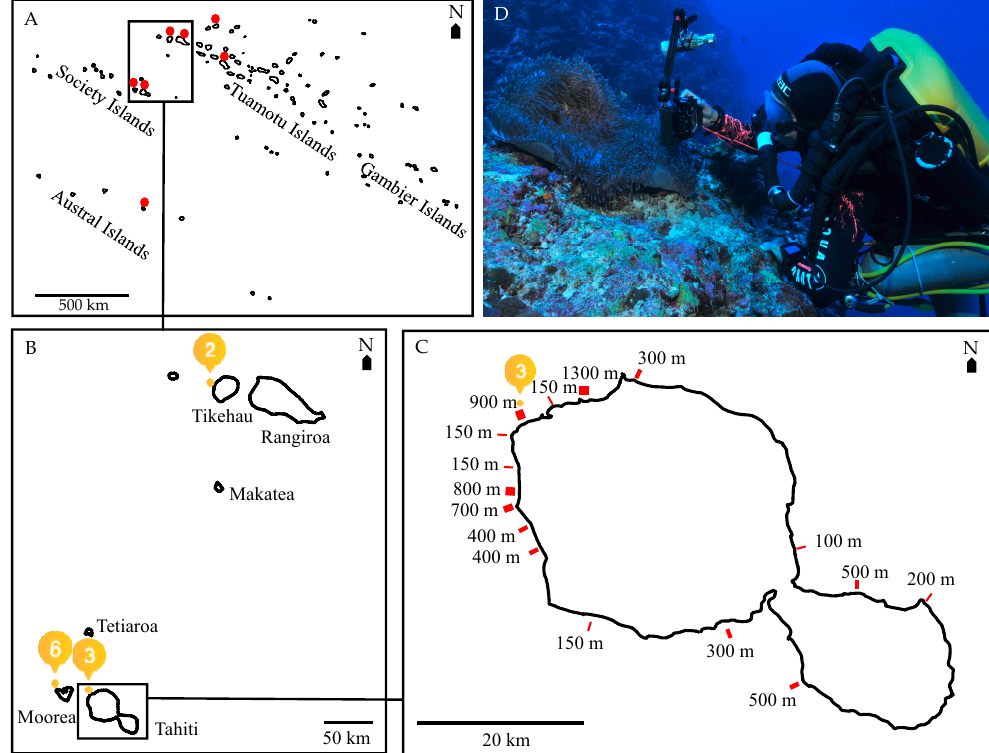
Figure 1. Anemone and anemonefish surveying in French Polynesia. ( A ) Map of French Polynesia indicating the seven high islands/atolls that were surveyed from 2011–2021 (black triangles: no anemonefish found, red triangles: only shallow anemonefish found, blue triangles: presence of anemonefish at both shallow and mesophotic depths). ( B ) Map of the three high islands/atolls where orange-fin anemonefish, Amphiprion chrysopterus , were observed both in the shallow and mesophotic zone (>50 m depth): Moorea (17 ◦ 28.870 (cid:48) S, 149 ◦ 53.990 (cid:48) W) and Tahiti (17 ◦ 32.487 (cid:48) S, 149 ◦ 37.568 (cid:48) W) in the Society archipelago and Tikehau (15 ◦ 1.057 (cid:48) S, 148 ◦ 17.184 (cid:48) W) in the Tuamotu archipelago (blue triangles represent the location and the numbers represent the number of mesophotic anemonefish found). ( C ) Map of Tahiti indicating the 18 shallow and mesophotic transects and their lengths that were surveyed from 2011–2020. ( D ) A scuba diver (AH) using a rebreather and trimix gaz, photographing A. chrysopterus at 55 m in Tikehau